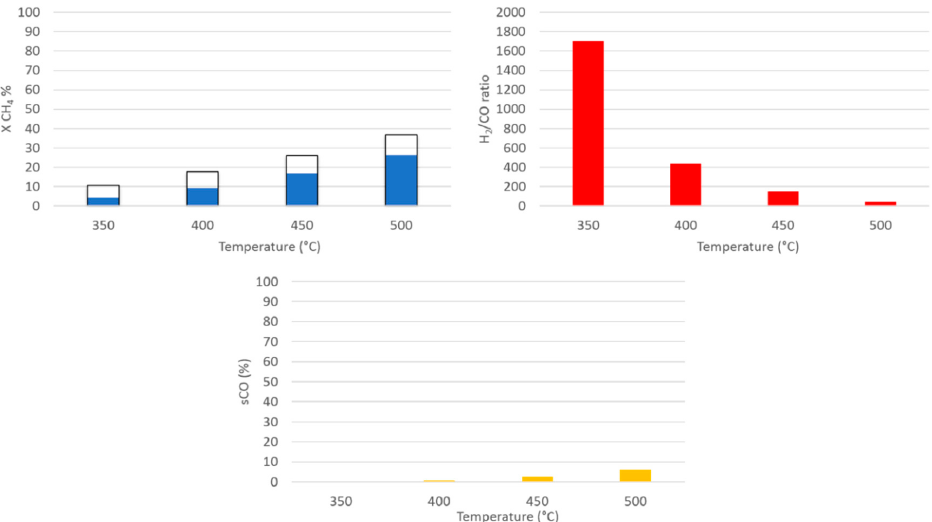
Figure 6. Comparison among tests carried out on Rh0.6-CL-R-CZOm at 30,000 h − 1 , 1 atm and S/C 3. The graphs report the methane conversion (blue) with respect to the equilibrium values (white bars with black frames), H 2 /CO ratio (red), and CO selectivity (yellow) versus different T. The Y scale related to the H 2 /CO-ratio graph is very different from the others due to the large values.